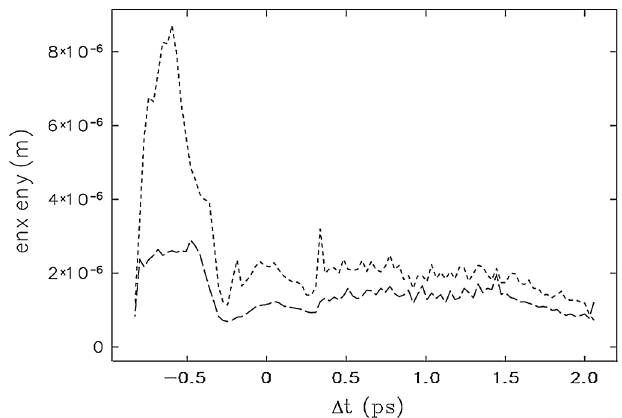
FIG. 9. Slice horizontal (short dashed line) and vertical (long dashed line) normalized emittance at the exit of BC2 ( R 56 ¼ (cid:2) 30 mm ), after the linear energy chirp removal; the bunch head is for negative time coordinates. The projected normalized horizontal emittance for 60% of the particles in the transverse phase space is 2 mm